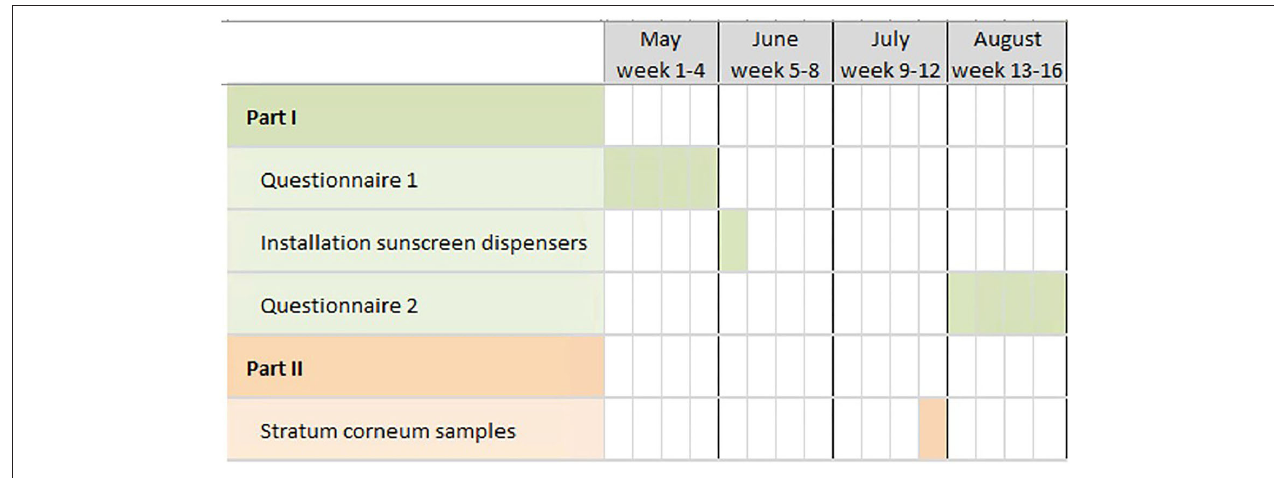
FIGURE 1 | Gantt chart of the study